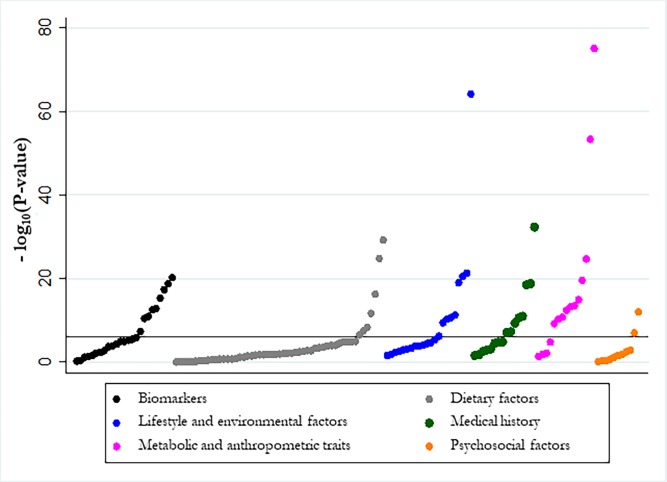
Manhattan plot for 142 associations between risk factors and T2DM.The horizontal line corresponds to the significance threshold of P <10−6.